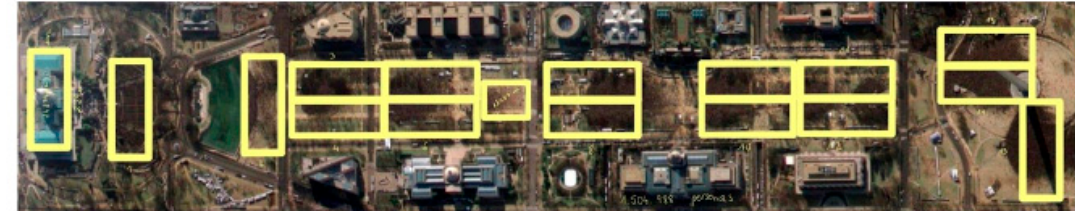
Figure A1. Statement of the task “the President’s supporters” translated into English (source: prepared by the authors).